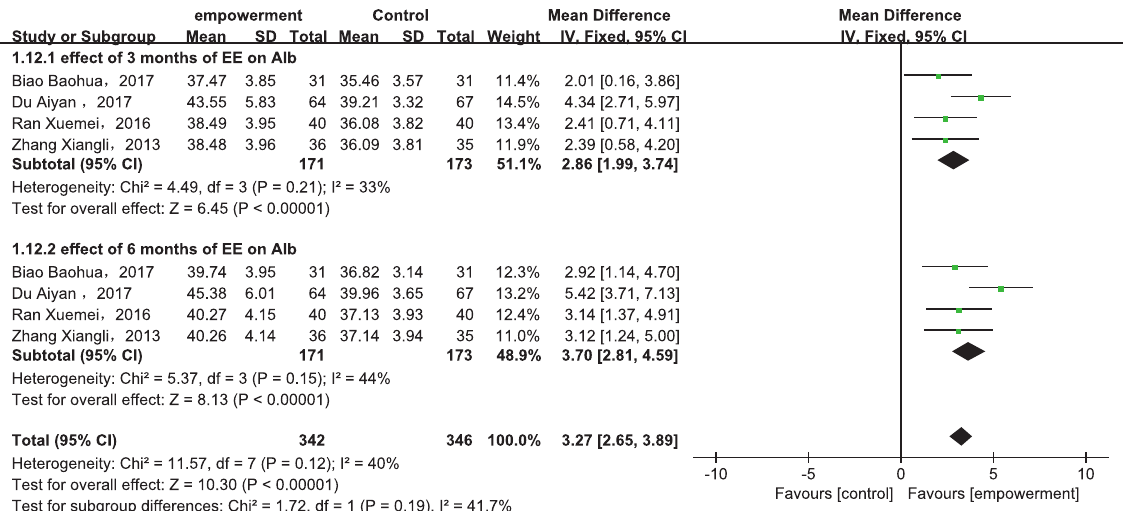
Figure 7. Comparison of albumin between empowerment education intervention group and traditional education